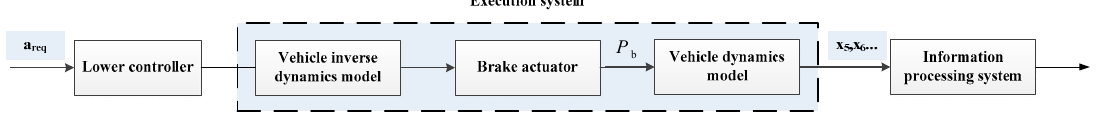
Figure 19. The structure of the lower controller.